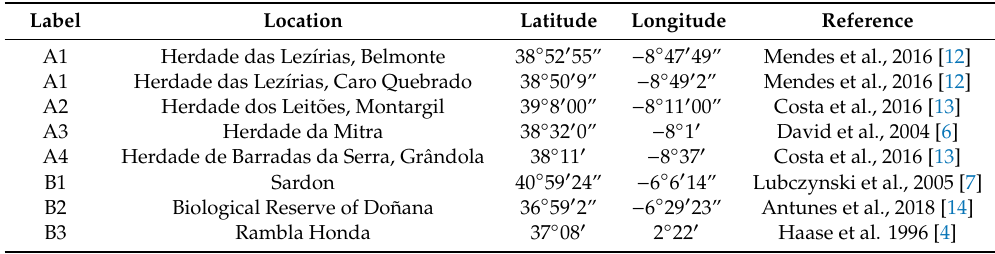
Table 2. Locations where groundwater-dependent vegetation (GDV) was identified in the IP, using in situ methods. Labels refer to regions shown in Figure